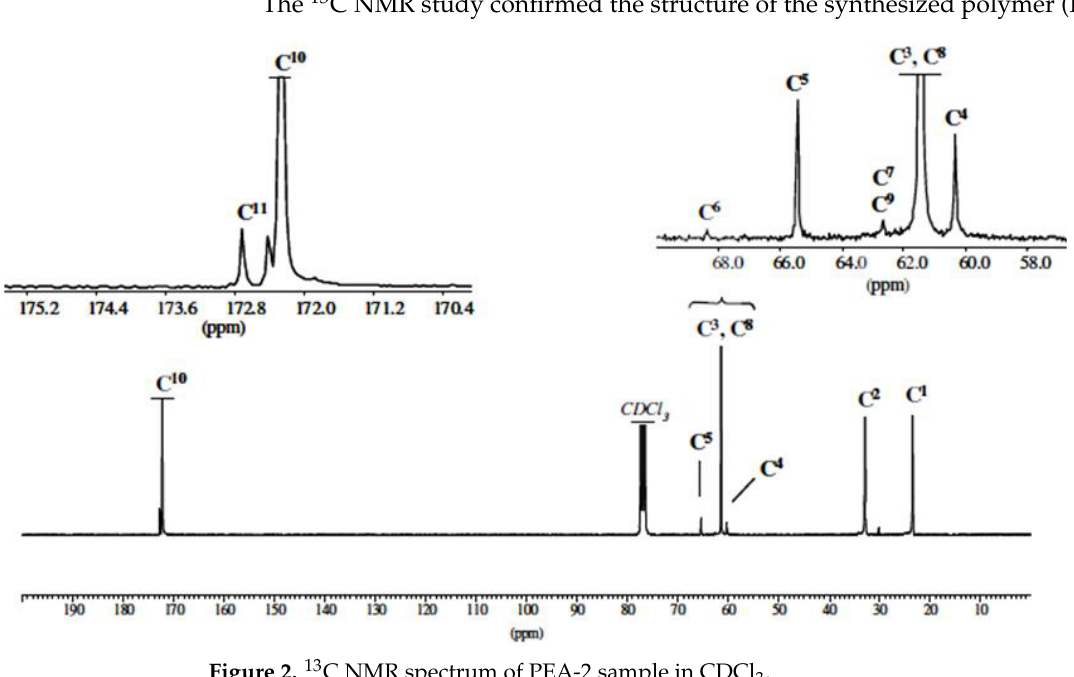
Figure 2. 13 C NMR spectrum of PEA-2 sample in CDCl 3.